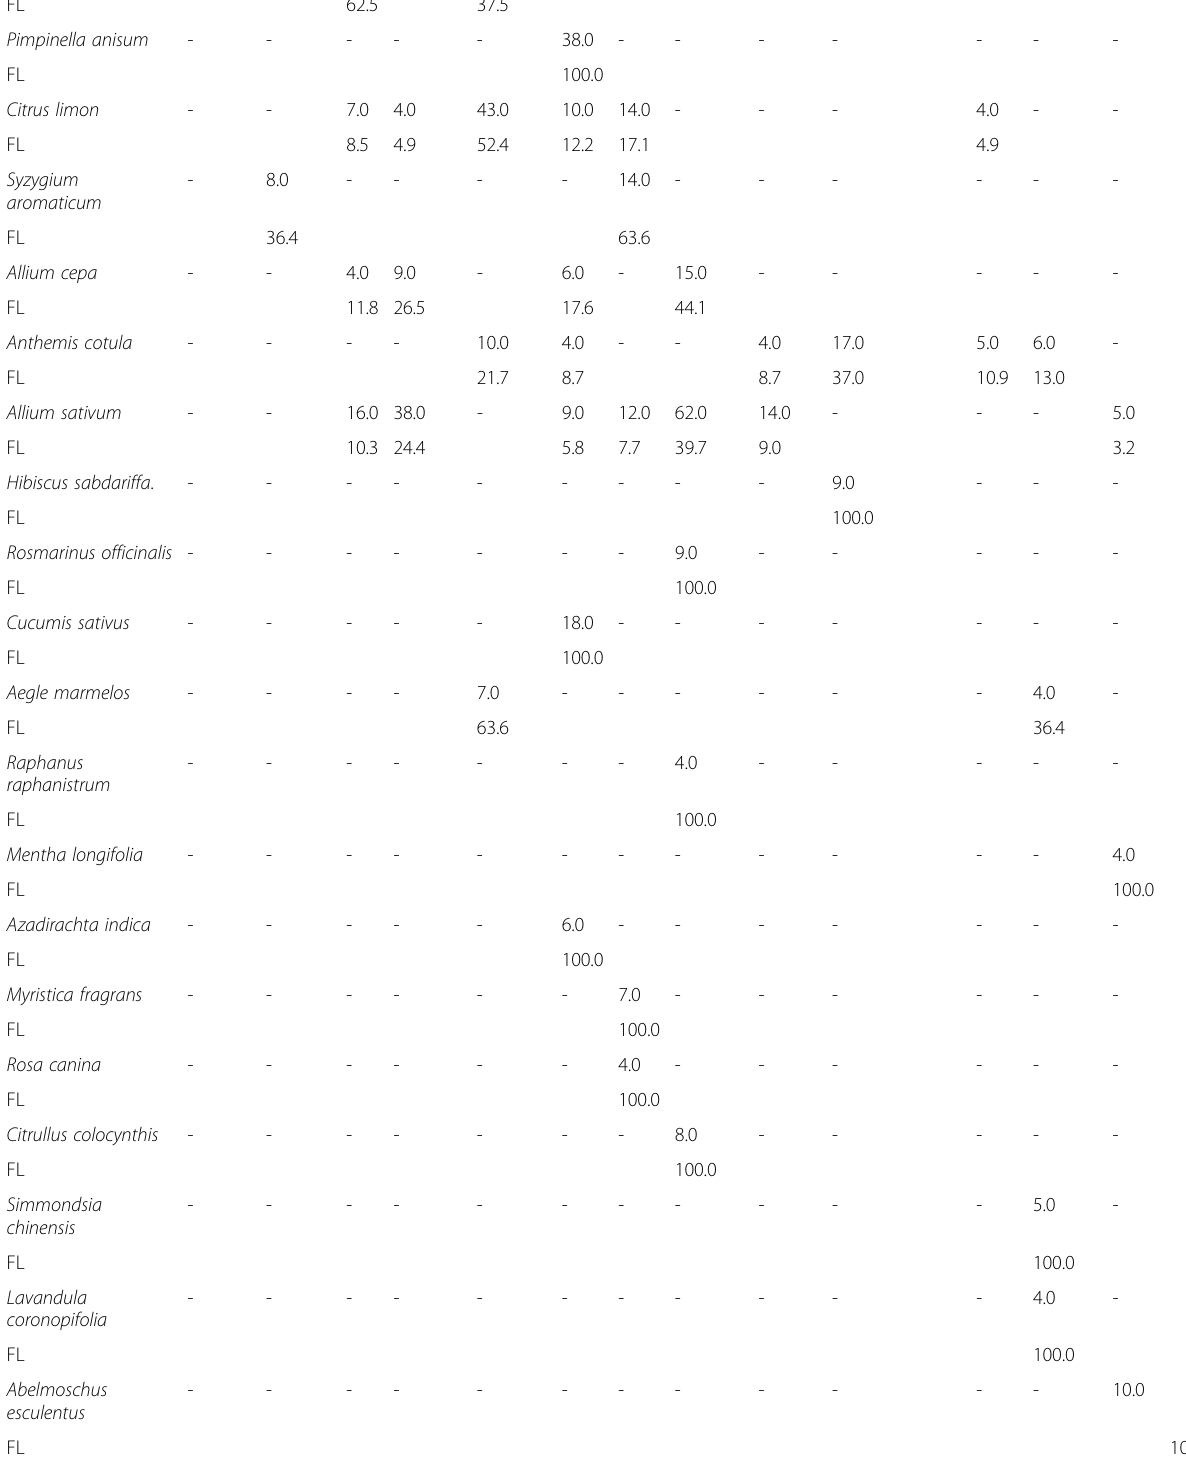
Table 3 Plants used as home remedies for treatment of hair and hair scalp in the West Bank/Palestine (Continued) FL 62.5 Pimpinella